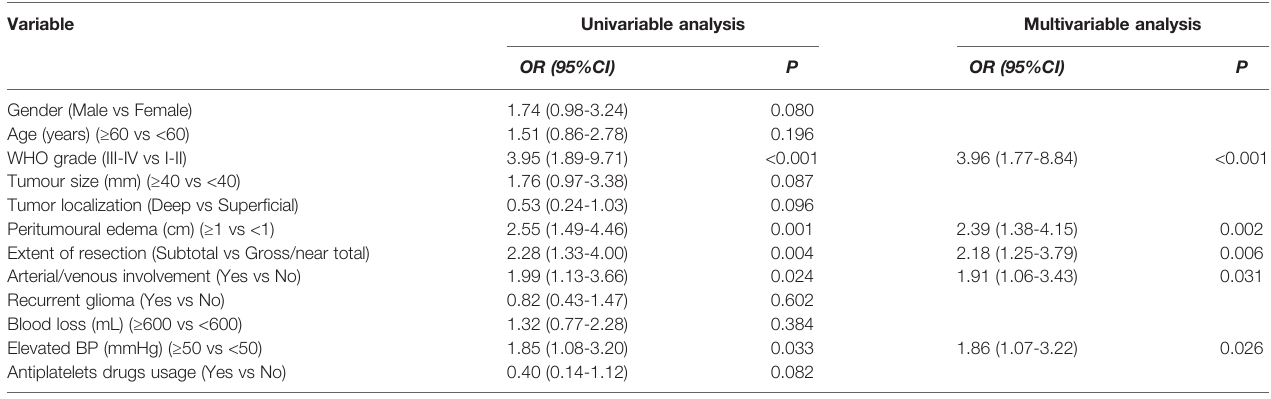
TABLE 3 | Clinical risk factors for prediction of reoperations after glioma resection.